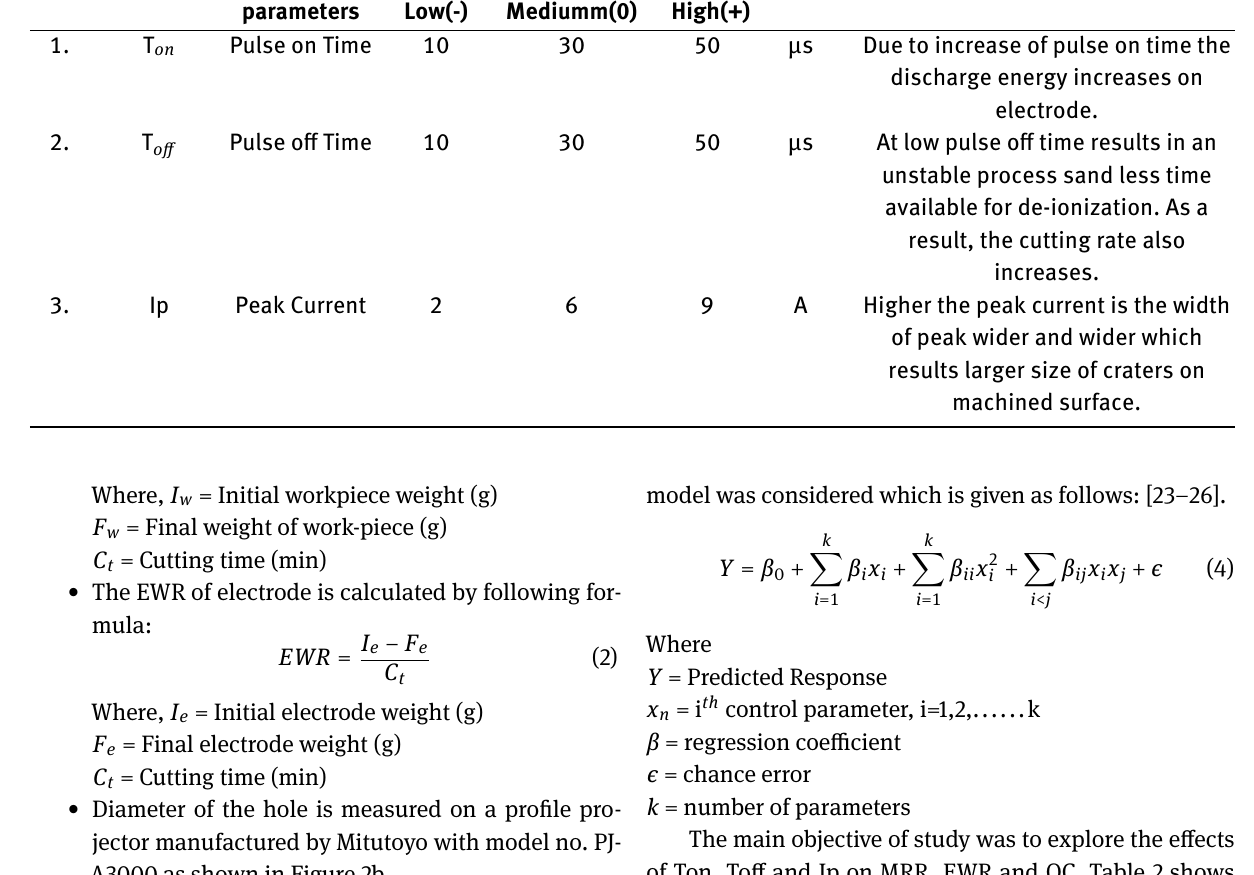
Table 2: Parameters and their levels of experimental design S.No. Symbols